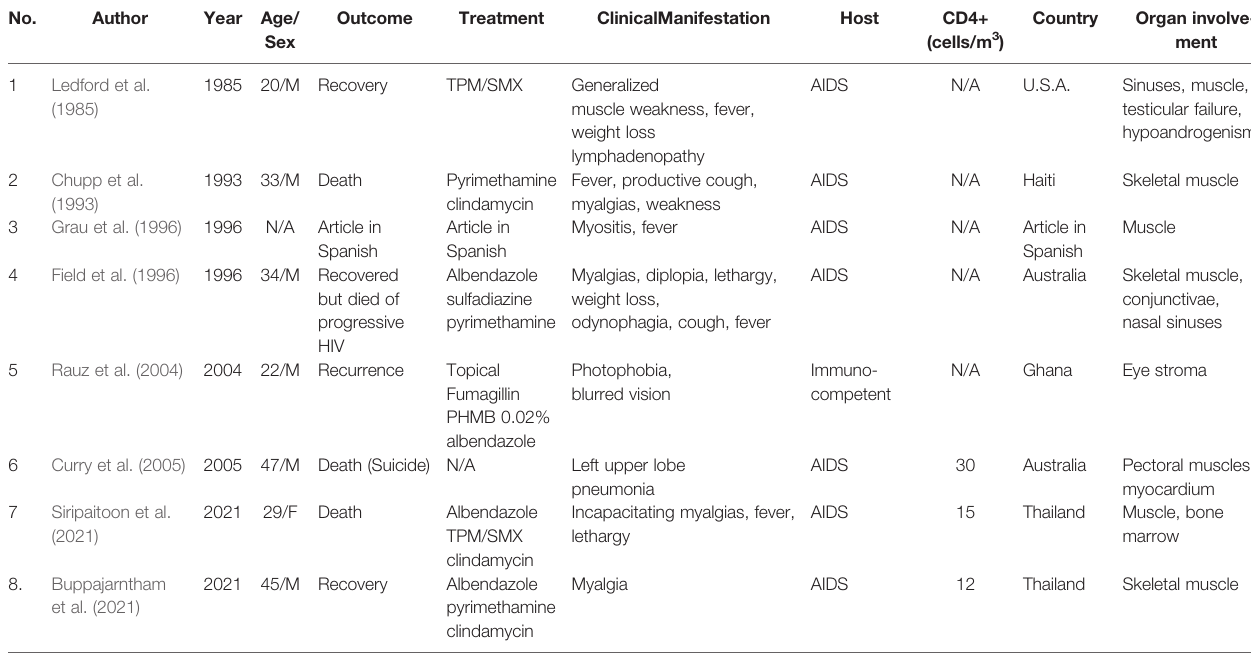
TABLE 3 | Trachipleistophora hominis cases.